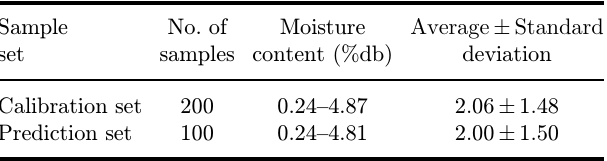
Table 1. Reference values for moisture content in rubber sheets analyzed using standard laboratory